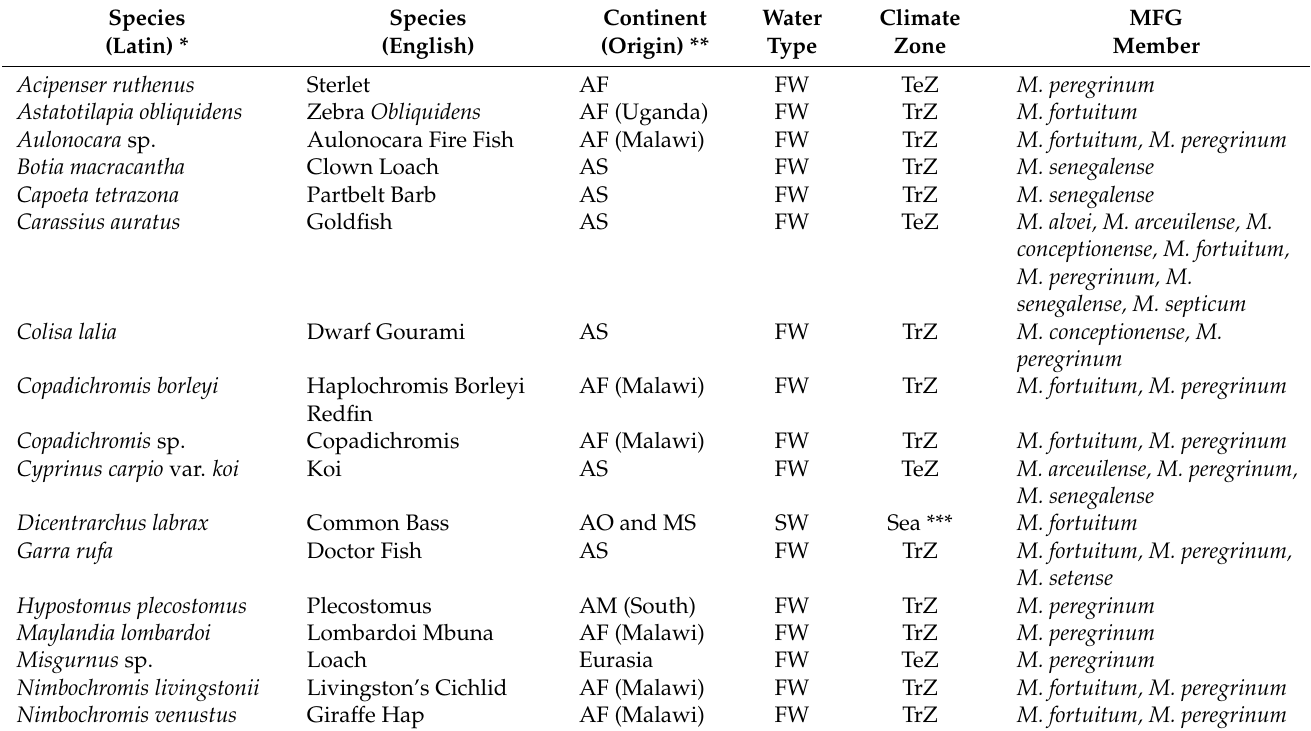
Table interpretation. * In alphabetical order; ** Year of description [2] (LPSN: List of Prokaryotic names with Standing in Nomenclature https://lpsn.dsmz.de/ (accessed on 30 September 2021); *** Mugetti et al. [1] (Table 2). Table 2. Characteristics of examined infected freshwater and saltwater fish with mycobacteriosis in the study carried out by Mugetti et al.